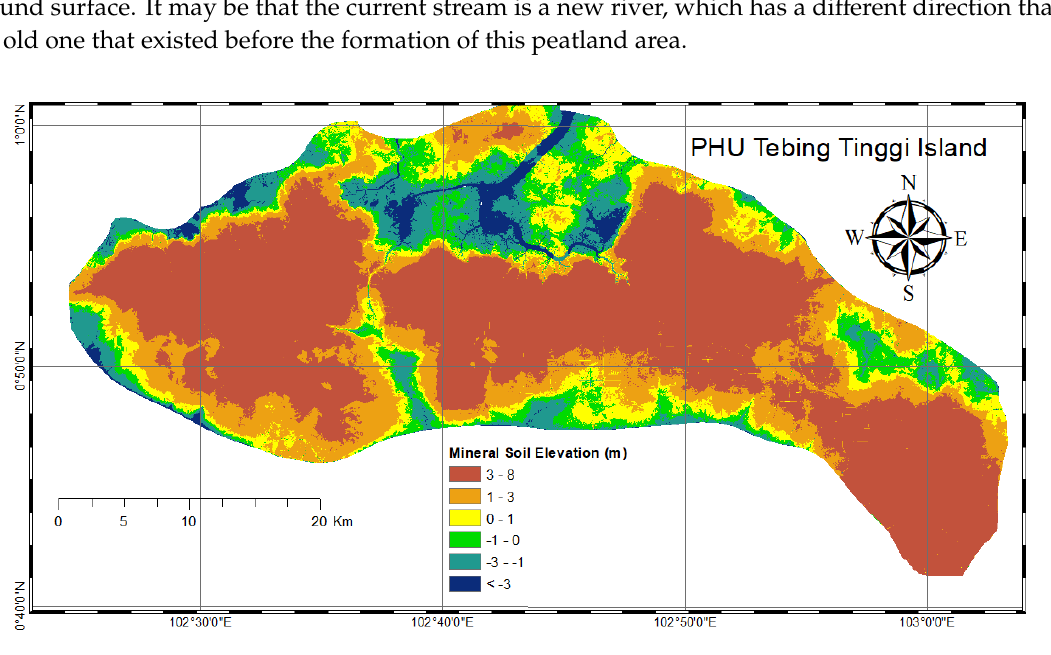
Figure 2. Mineral Soil Elevation above the local Mean Sea Level (MSL).